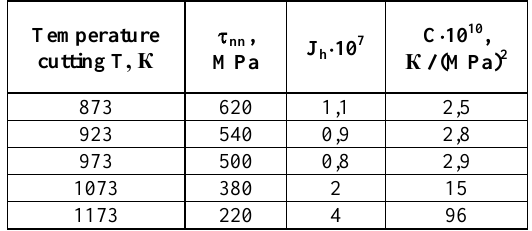
Table 1. Turning of KhN70VMTYUB alloy with VK6M cutter; cutting speed V = 15 65 m / min; depth